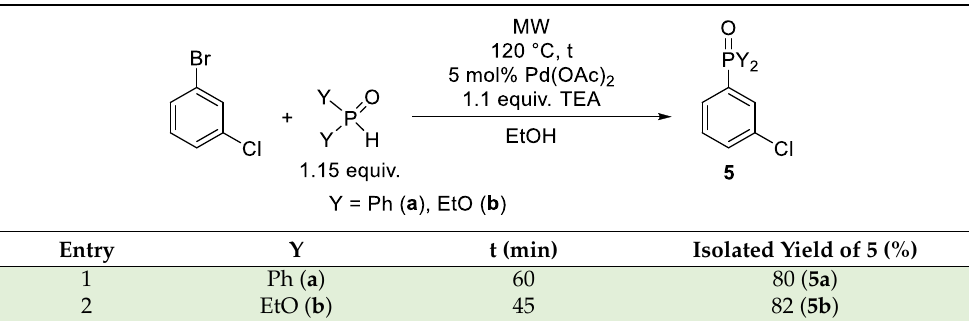
Table 6. P–C coupling reactions of 3-chloro-bromobenzene. Table 6. P – C coupling reactions of